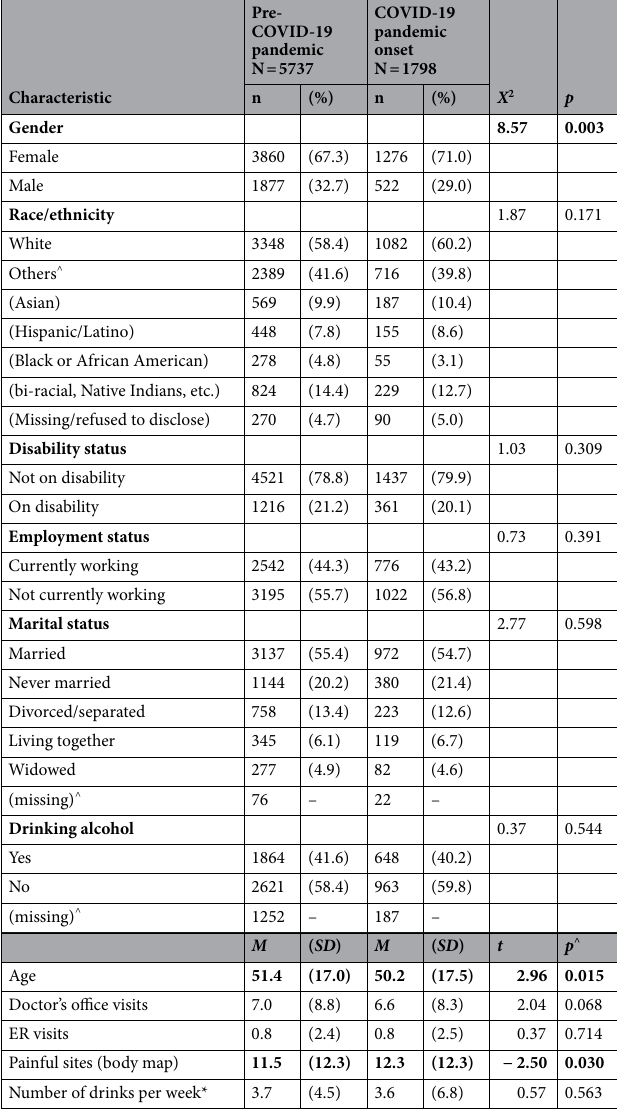
Table 1. Sample characteristics of pre- and post-COVID-19 pandemic onset cohorts. Bold font indicates significance at p < 0.05. Others ^ : Break downs of other races are listed below in parenthesis; p ^ FDR adjusted p values; *n = 1709 of pre-covid-19 sample and n = 583 of post-covid-19 sample provided the